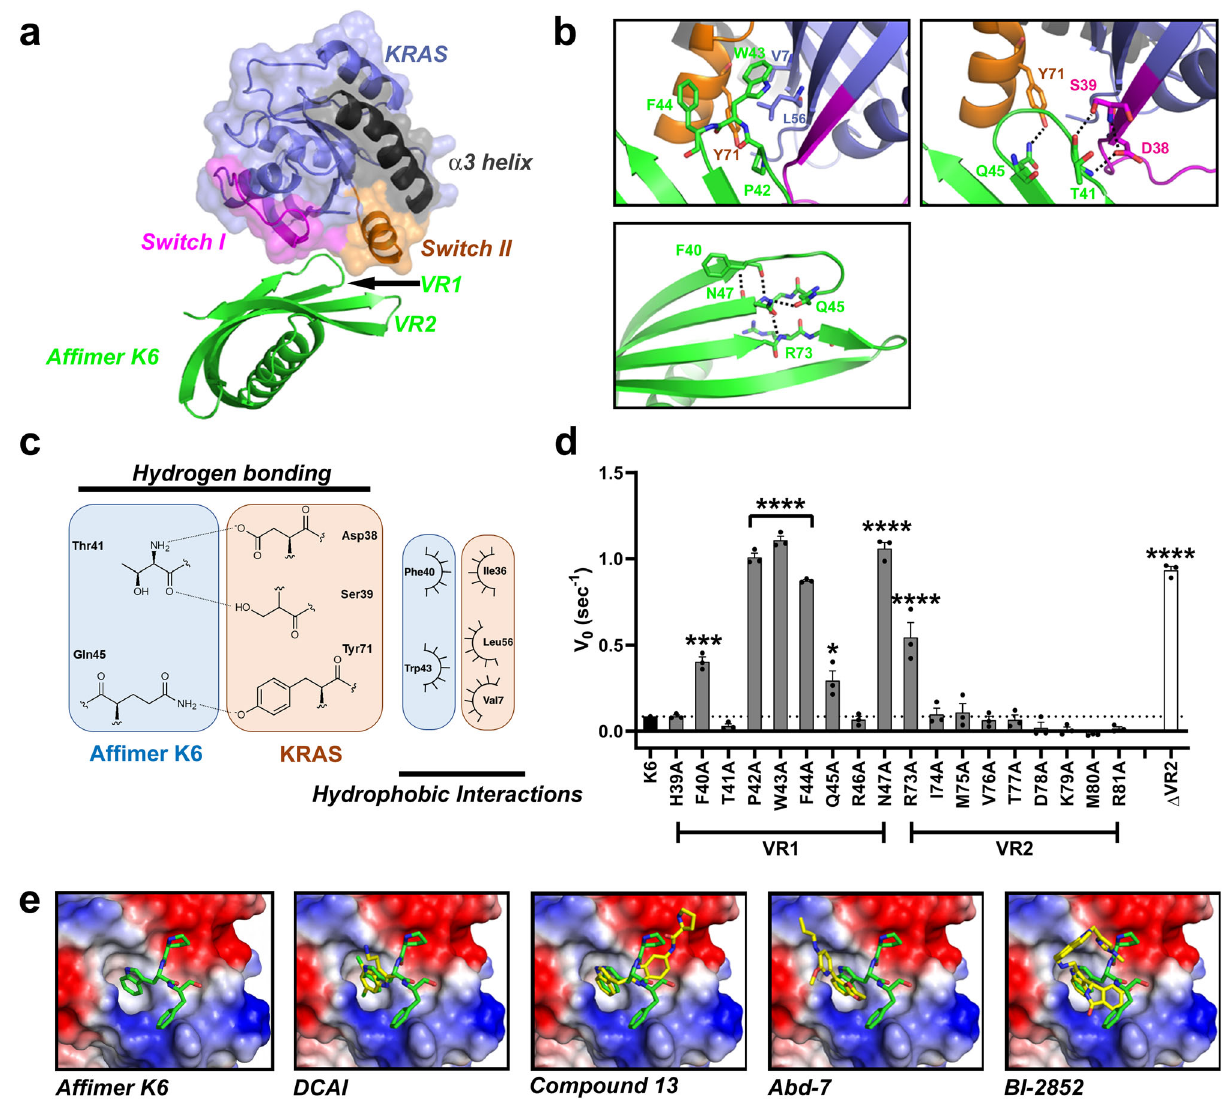
Fig. 4 Variable region 1 of Af fi mer K6 binds between Switch I and Switch II of KRAS. a Af fi mer K6 (green) was co-crystallized with KRAS GDP (slate) and solved to a resolution of 1.9 Å. The switch I (magenta), switch II (orange) and α 3 helix (black) are depicted, showing their relative positioning around variable region 1 of Af fi mer K6. b Intramolecular and intermolecular interactions in the KRAS:Af fi mer K6 co-crystal structure are depicted; black dotted lines represent the hydrogen bonds that stabilize the critical hydrophobic contacts. c Af fi mer K6 (VR1) and KRAS interactions shown in planar form. Hydrogen bonds are shown as black, dotted lines between the contributing atoms; additional hydrophobic interactions are represented by arcs, their spokes radiating towards the residues they contact. (Data was generated using PDBePISA (CCP4i) 31 and veri fi ed in MacPyMOL). d Alanine scanning data of the variable regions of Af fi mer K6 highlights Af fi mer residues important for inhibition of nucleotide exchange and the importance of VR2. This highlights the residues that are important for both KRAS:K6 interactions and intra-Af fi mer interactions that stabilize the conformation of Af fi mer K6. Unaltered K6 is shown in black, variable region 1 residues are shown in dark gray, variable region 2 residues in light gray, and removal of variable region 2 ( Δ VR2) in white. ( n = 3 independent experiments). e Comparison of Af fi mer K6 tripeptide, P42, W43, F44, (green) with the small molecules (yellow) that bind the same SI/ SII pocket. Data are mean ± SEM, One-way ANOVA with Dunnett ’ s post hoc test * p = 0.0224 Q45A ** p = 0.0002 F40A **** p < 0.0001 P42A, W43A, F44A, R73A, and Δ VR2. Images were generated in MacPyMOL v1.7.2.3, and ChemDraw Prime 16.0. VR variable